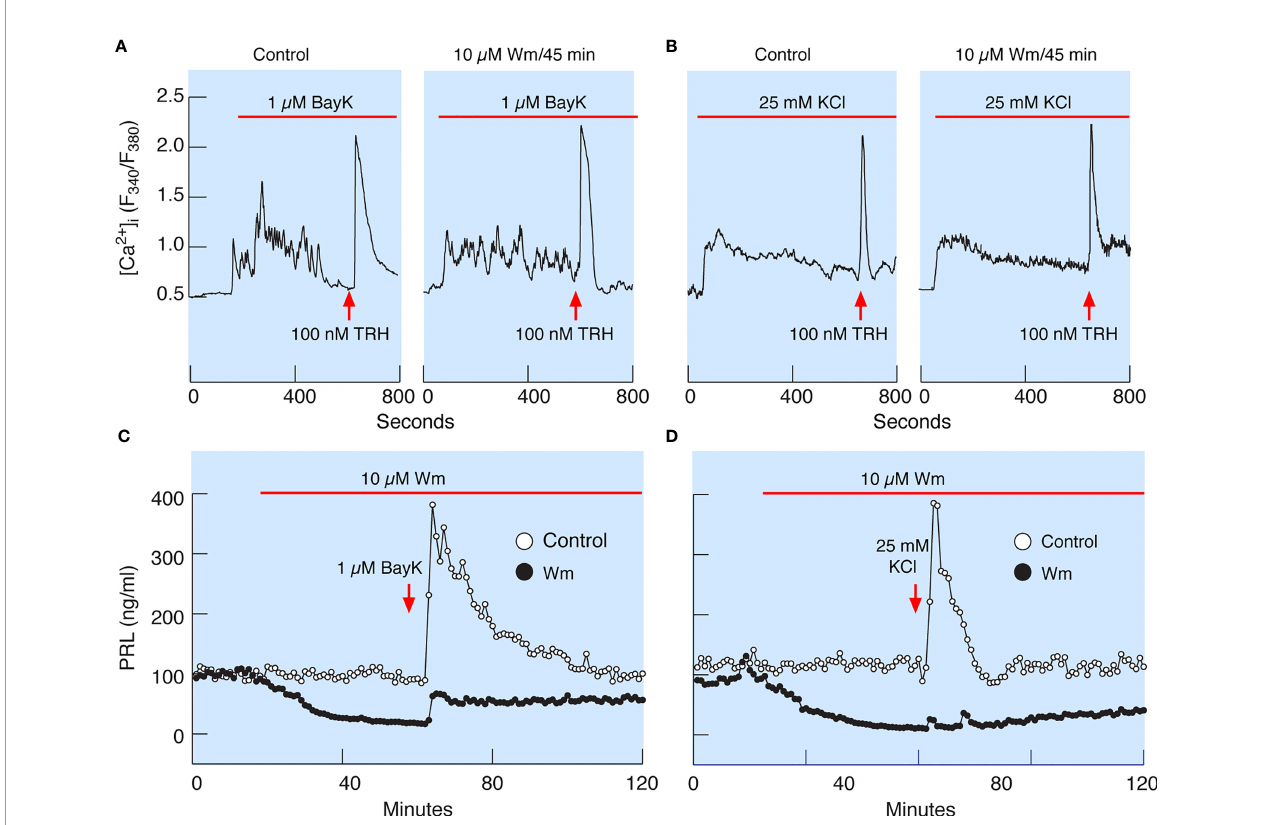
FIGURE 7 | Wm-induced inhibition of PRL release occurs downstream of spontaneous and augmented voltage-gated calcium in fl ux. (A) Bay K8644 (BayK), an L- type calcium channel agonist, induced rise in cytosolic calcium concentration ([Ca 2+ ] i ), which was not affected by treatment of cells with 10 µM Wm for 45 min. (B) Facilitation of voltage-gated calcium in fl ux by high K + -induced depolarization of cells was also not affected by treating the cells with 10 µM Wm for 45 min. Horizontal red bars indicate the duration of BayK and high K + treatments, and the arrows indicate the time of application of thyrotropin-releasing hormone (TRH) in the absence or presence of Wm. In addition to TRH, cells were stimulated with 1 µM dopamine, to identify lactotrophs (not shown). Traces shown are representative from three independent experiments. (C, D) Although Wm pretreatment did not affect the facilitated voltage-gated calcium in fl ux, the stimulatory effect of BayK (C) and high K + (D) on PRL release was dramatically reduced in pituitary cells perfused with Wm-containing medium for 45 minutes. The mean ± SEM values for PRL release (ng/ml) during the fi rst 20 min of BayK treatments in the absence and presence of Wm in four experiments were: 210 ± 13 vs . 42 ± 2.4; 146 ± 10 vs . 31 ± 1; 184 ± 11 vs . 35 ± 2; and 481 ± 24 vs . 193 ± 11. The mean ± SEM values for two high potassium experiments in the absence and presence of Wm were 173 ± 21 vs . 18 ± 1; and 255 ± 172 vs . 5 ± 3. In all cases, P <